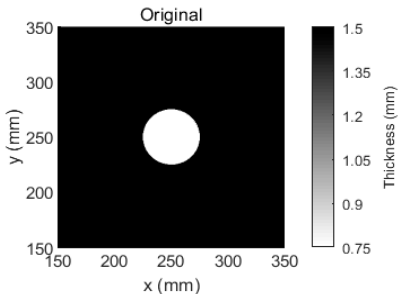
Figure 5. Aluminum plate with a thickness of 1.5 mm and a 50-mm-diameter circular flat-bottomed hole. The thickness loss is 50% within the flaw.